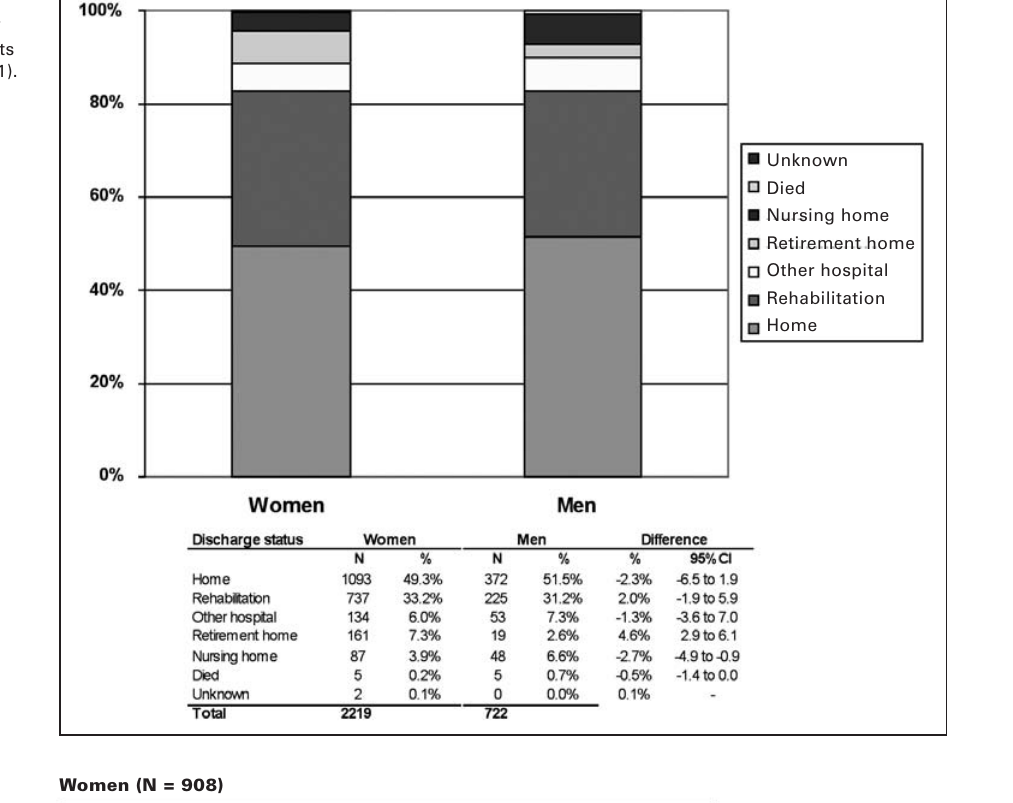
Mean of lowest measuredT-scores, by fracture type and by gender (n =